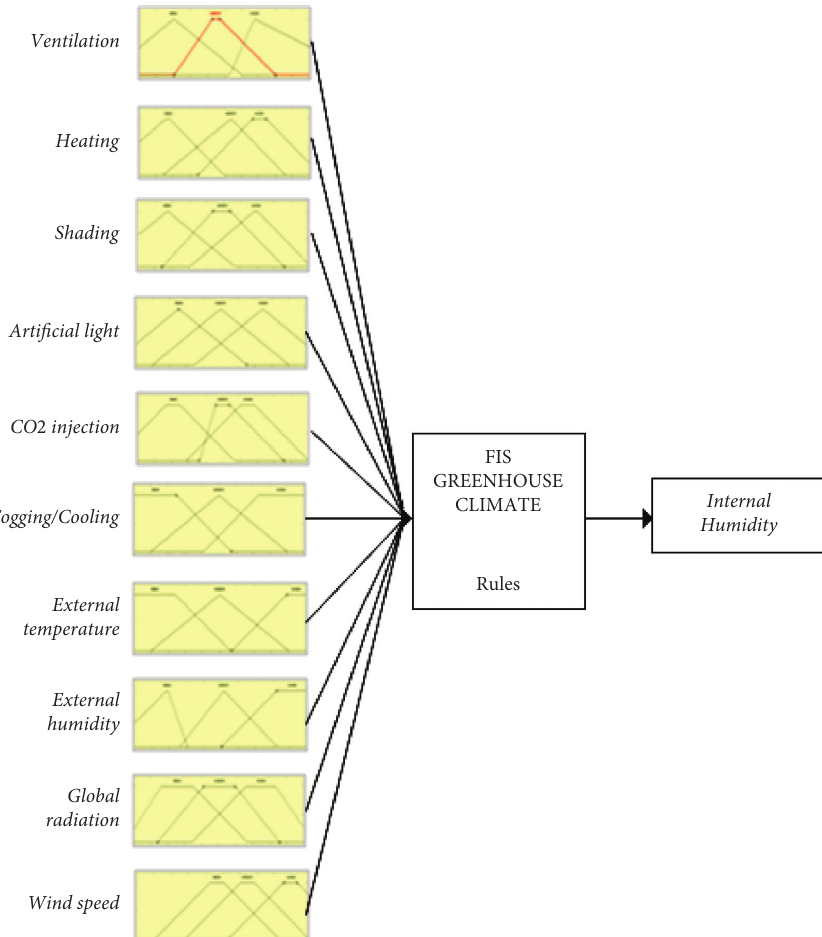
Figure 8: Block diagram of the fuzzy inference system for greenhouse humidity prediction and control (adapted from